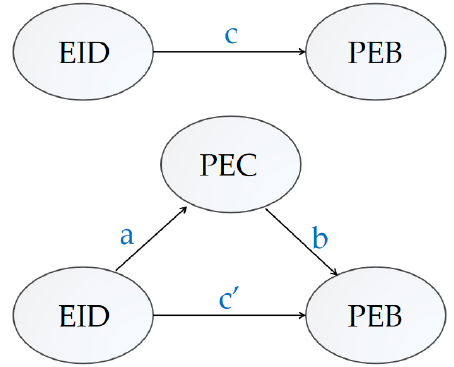
Figure 2. Schematic diagram of the mediation effect of PEC.